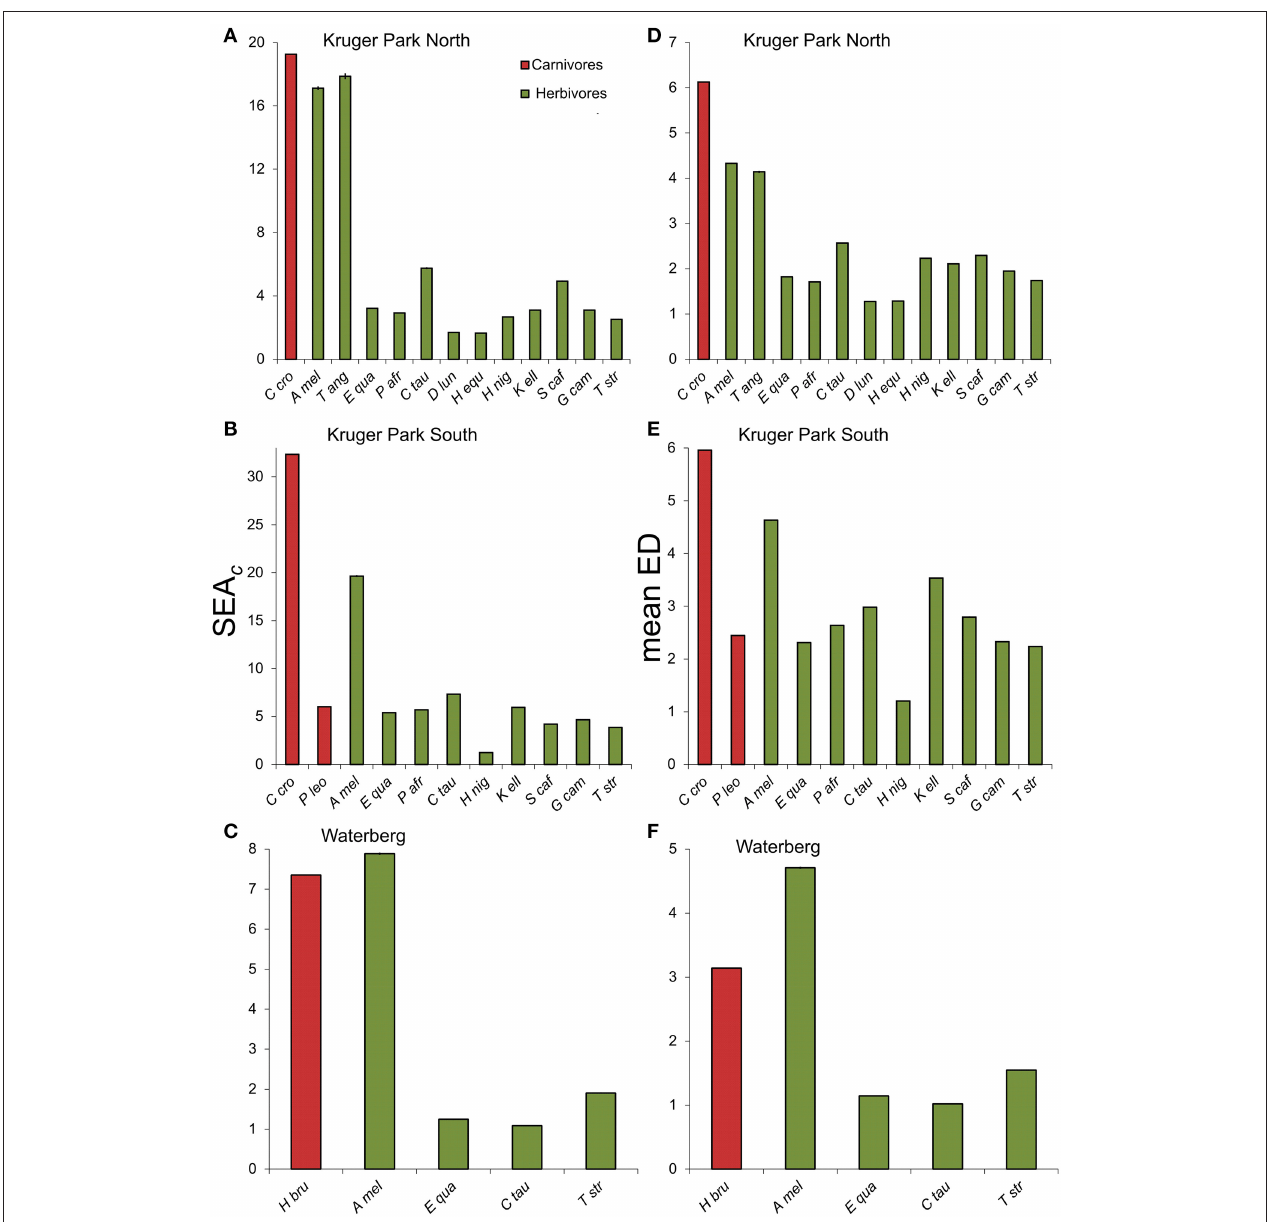
FIGURE 5 | Isotopic variability in carnivore and herbivore populations, measured as standard ellipse areas (SEA c ) in carbon and nitrogen isotope bi-space (A–C), and as mean Euclidean Distances (ED) between pairs of individuals (D–F). Bar heights and error bars depict means and 95% confidence limits from 10 4 randomized permutations (random subsamples were held at and below the maximum sample size for carnivores within each assemblage).